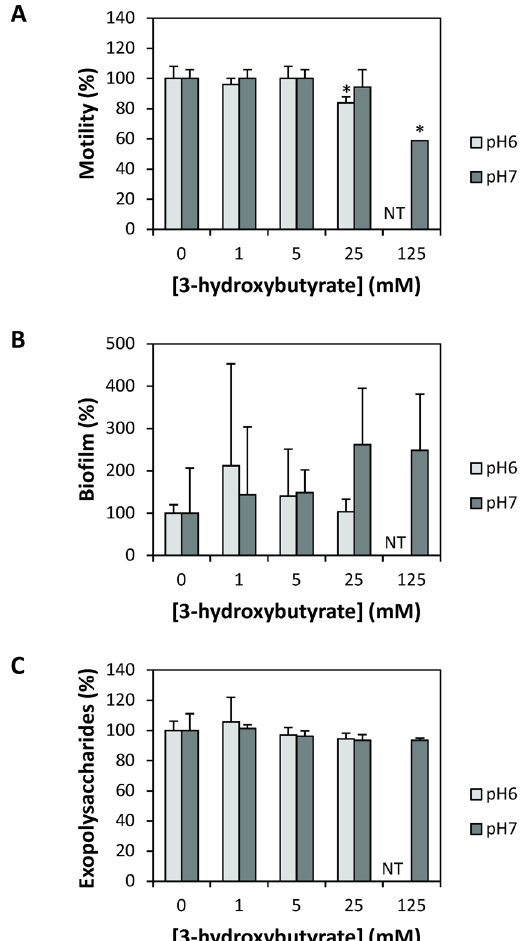
Figure 4. Motility (panel A), biofilm formation (panel B) and exopolysaccharide production (panel C) of Vibrio campbellii ATCC BAA-1116 in the presence of different concentrations of 3-hydroxybutyrate, at pH6 or pH7. Error bars represent the standard deviation of three replicates. Bars that are significantly different from the treatment without 3-hydroxybutyrate are marked with an asterisk (P < 0.05). NT: Not